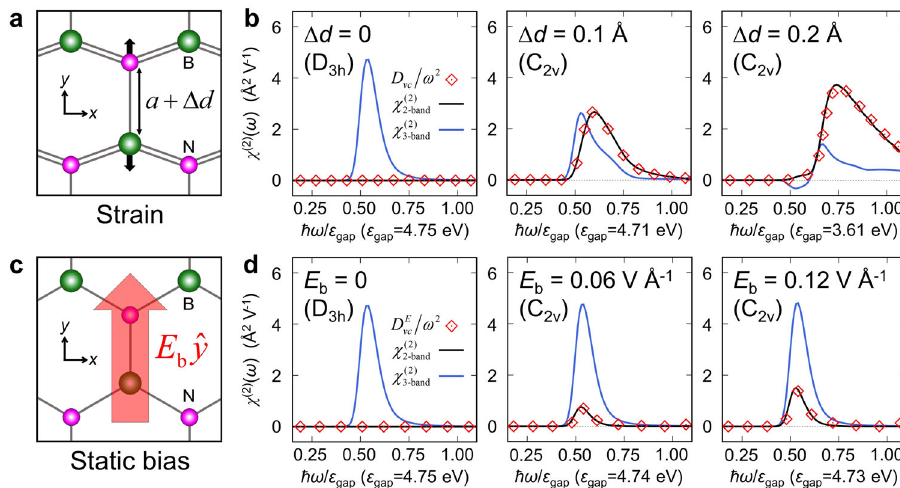
Fig. 3 The two-band and three-band contributions to the second harmonic generation (SHG) susceptibility compared with the interband Berry curvature dipole (BCD). a The monolayer h-BN, in which the B-N bond lengths are extended by Δ d in the y -direction. The single (double) lines represent the long (short) bonds of the strained h-BN. b The comparison of 2-band and 3-band transition terms of SHG susceptibility spectra with the interband BCD for gradually increasing Δ d values. c The un-strained h-BN, whose symmetry is adjusted by the static electric fi eld bias of strength E b in the y -direction (the thick red arrow). d The same as b with varying E b